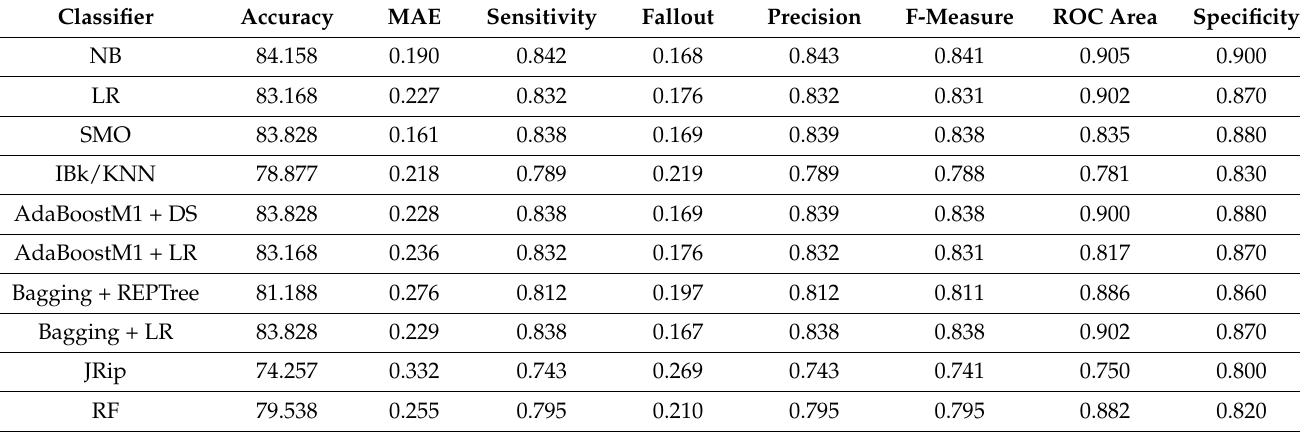
Table 8. Performance of the machine learning classifiers using the optimal attribute set found based on the correlation-based feature selection